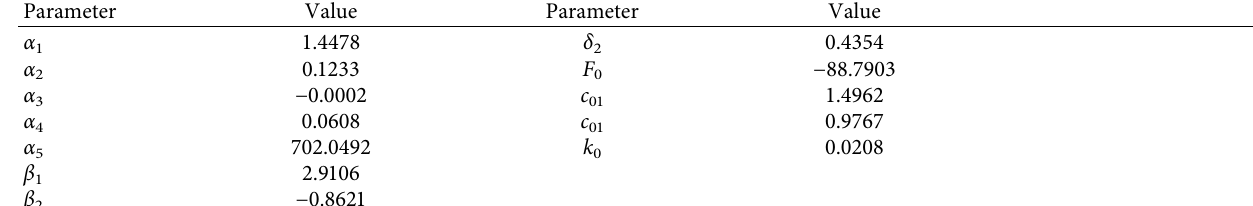
Table 4: Summary of identification results.